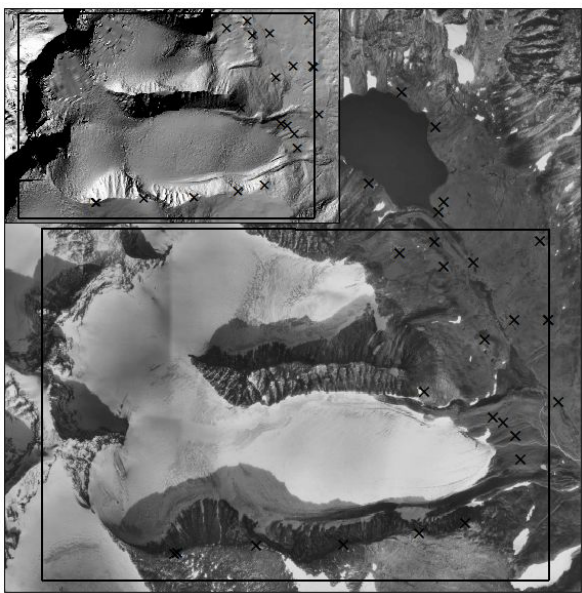
Fig. 2. Orthophoto and hill-shading of the corresponding DEM as computed from the aerial photographs of 1999. In addition, the lo- cations of the 26 dGPS reference points and the bounding box used for the shadow and snow cover statistics (cf. Table 1) are shown.